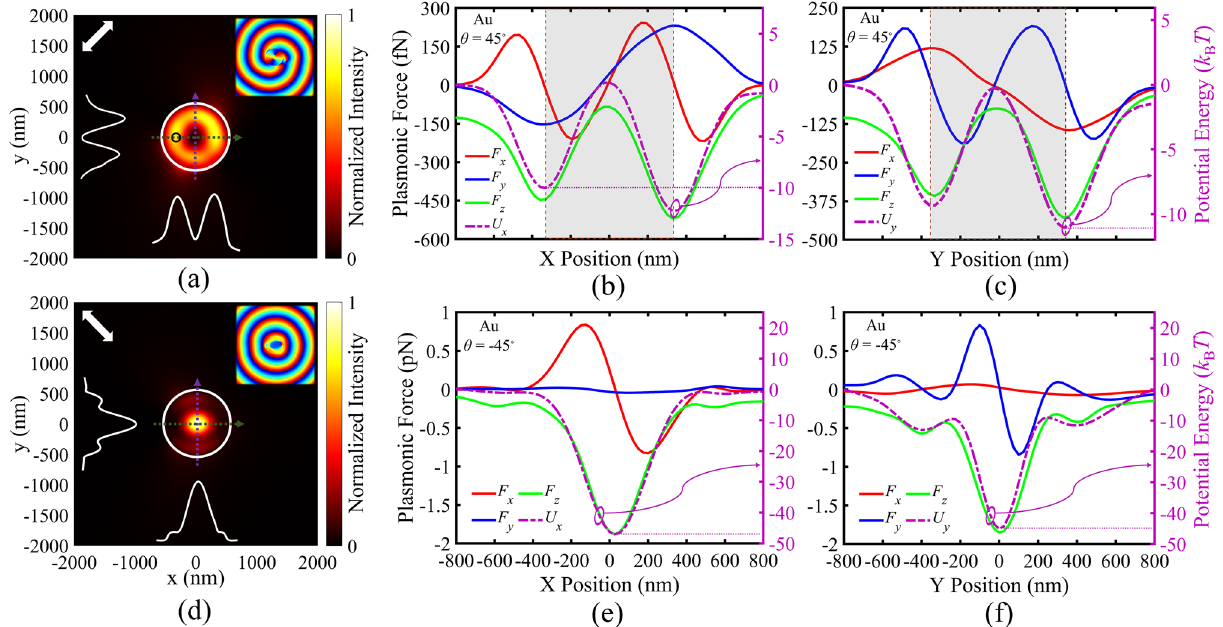
Figure 6. Normalized electric field intensity distribution of generated PV in MIM structure for θ = ( a ) 45° and ( d ) − 45°. Insets show phase distribution of E z field in the area. Plasmonic force analysis for a gold sphere with the radius of 80 nm in the PV field: ( b , c ) Calculated plasmonic forces F x , F y , F z and the corresponding potential well at various x -offsets and y -offsets along the dotted lines, respectively, for θ = 45°. The ring locations are labeled by dotted lines. Highlighted areas denote inside the vortex ring. ( e , f ) Calculated plasmonic forces F x , F y , F z and the corresponding potential well at various x -offsets and y -offsets along the dotted lines, respectively, for θ = − 45°. The orientation of θ is shown by white arrows. Circular white lines show boundaries of the circular hole etched in the top